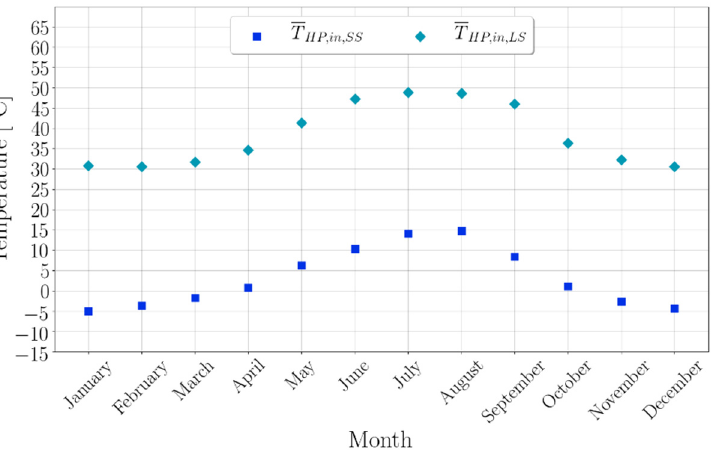
Figure 17. Monthly weighted inlet fluid temperatures at the source and load side of the heat pump.